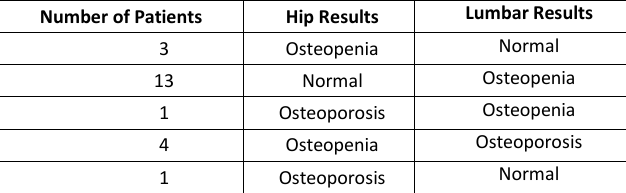
Table 3. The disagreement between DXA results from hip and lumbar spine regions. Lumbar spine and hip DXA results were consistent in 26